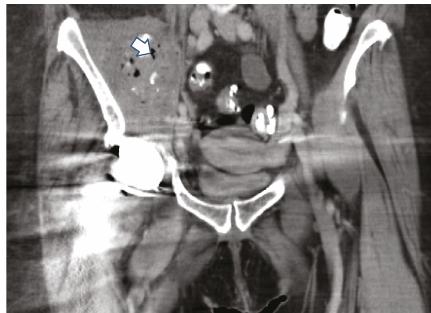
Figure 1: CT: right iliopsoas abscess with calci fi cations and air (arrowhead).